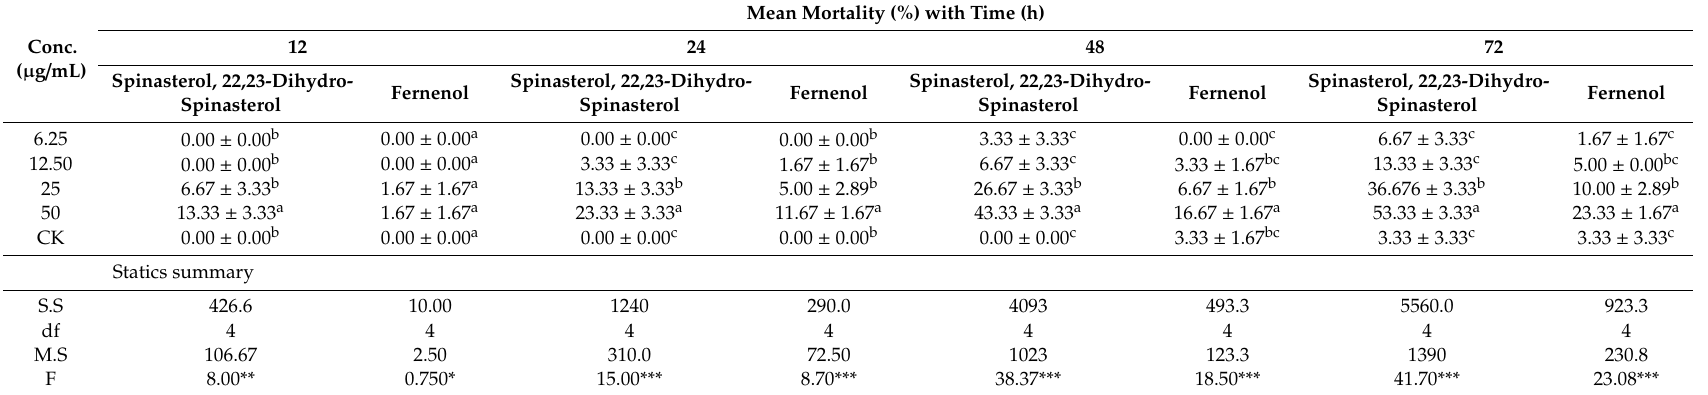
Table 3. Mortality of Brevicoryne brassicae by spinasterol, 22,23-dihydrospinasterol and fernenol via residual